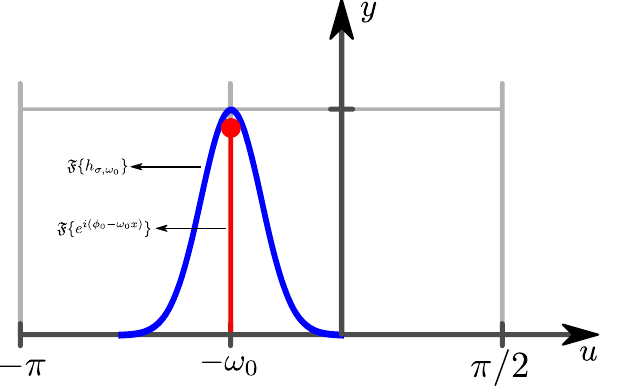
Figure 1. The red line represents an impulse at frequency ω 0 , which is the Fourier transform of a complex signal whose phase is a line with slope ω 0 . The blue line is the one-dimensional Fourier transform of the Gabor filter given by Eq. (7). The Gabor filter is tuned (or adapted) at the frequency ω 0 , passing only the information around this frequency ω 0